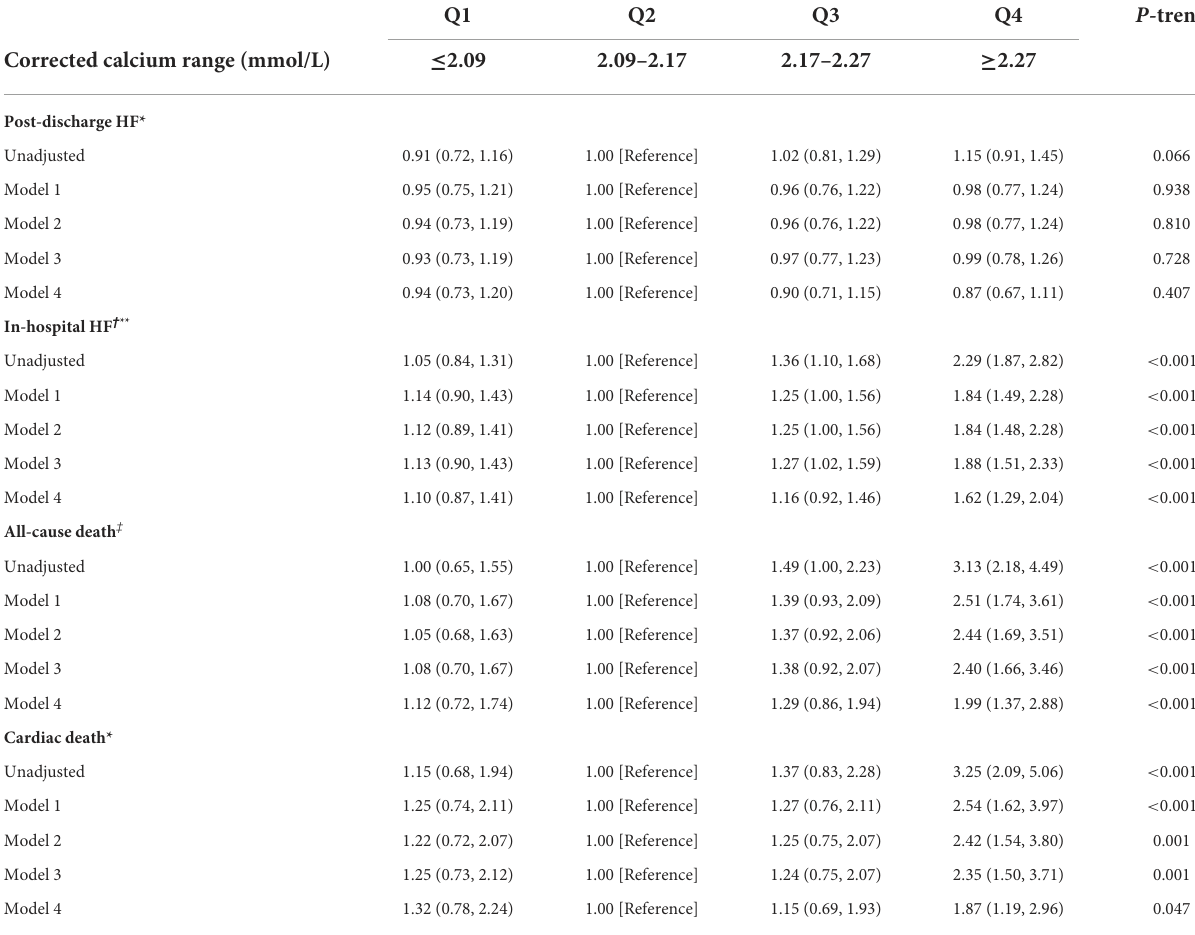
TABLE 6 Sub-distributional HRs, ORs, or HRs (95% CIs) associated with corrected calcium for clinical outcomes after acute myocardial